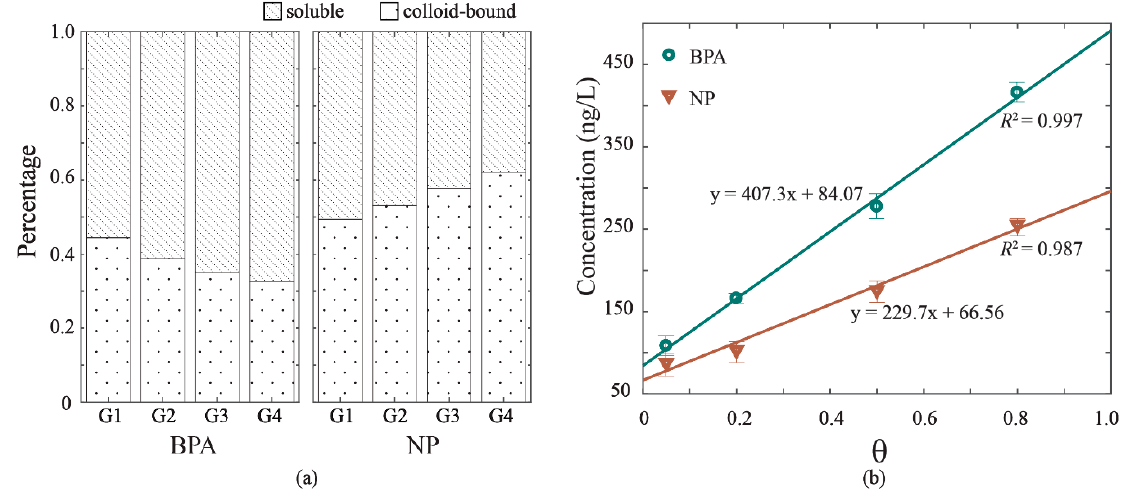
Figure 3. The release of bisphenol A (BPA) and nonylphenol (NP) in overlying water under hydrodynamic forces. ( a ) Distributions of BPA and NP in two phases: soluble and colloid-bound. ( b ) The correlations of total concentrations in overlying water and hydrodynamic intensity ( θ ).